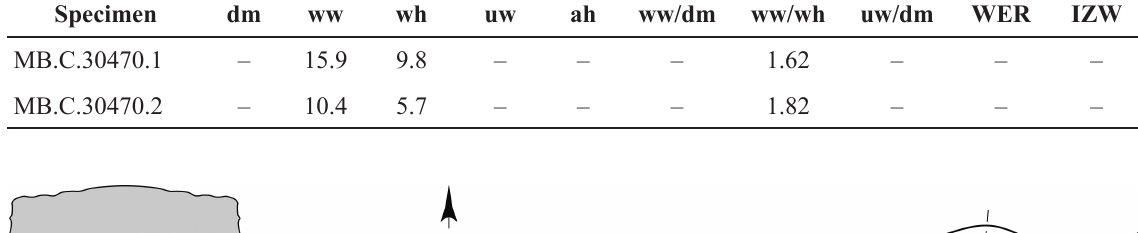
Table 9. Conch dimensions (in mm) and ratios of Vestinautilus papilio sp. nov. Specimen